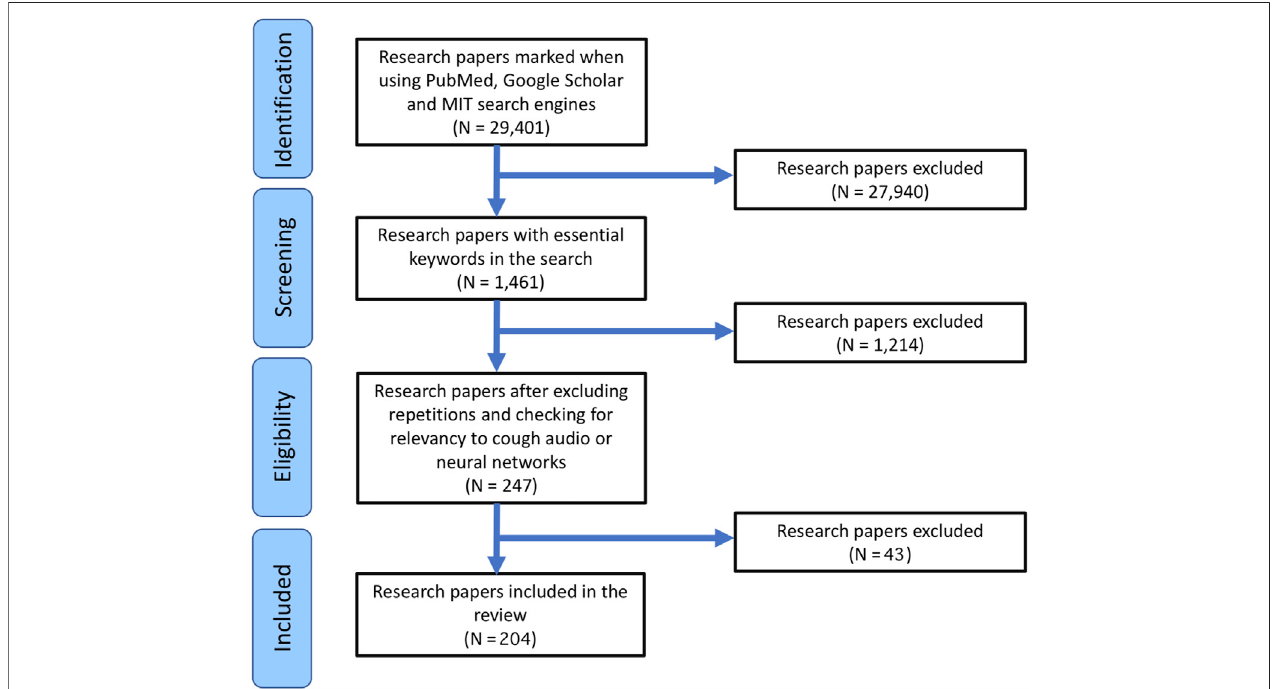
FIGURE 1 | Flowchart for methodology of reviewing